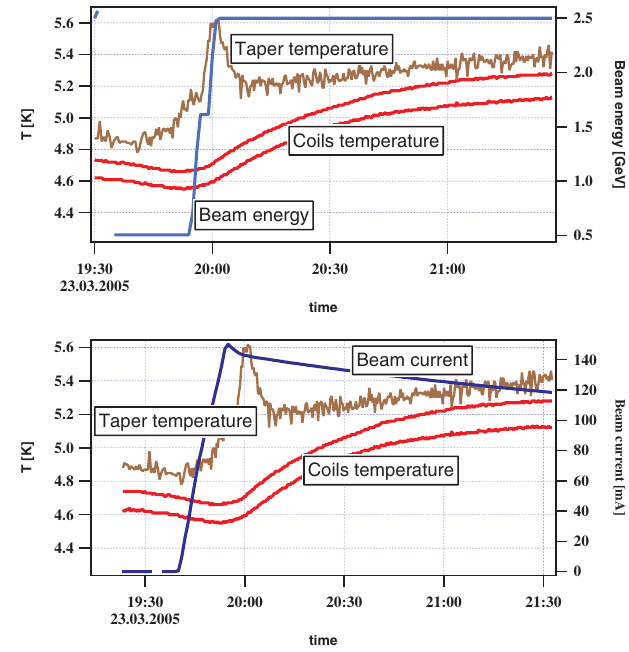
FIG. 7. (Color) The mechanism which heats the taper and the undulator coils seems to be different. The taper is heated both by the current (regardless of the energy) and the synchrotron radiation from the upstream bending magnets; the coils, on the other hand, are only affected by the synchrotron radiation from the upstream magnets and/or by thermal conductivity from the taper. Note that the taper temperature is about 40 K and this temperature is not indicated on the axis.